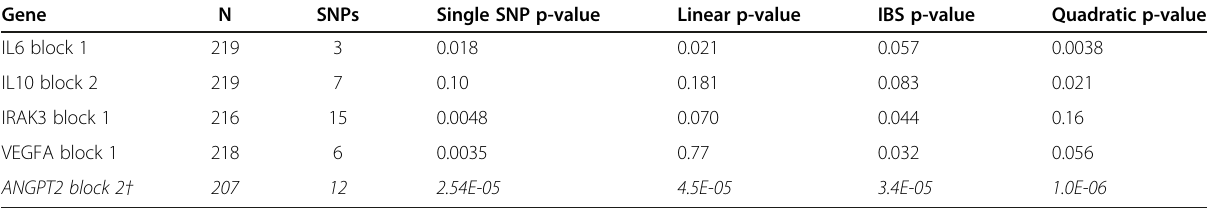
Table 3 Gene and haplotype ALI associations in African Ancestry trauma